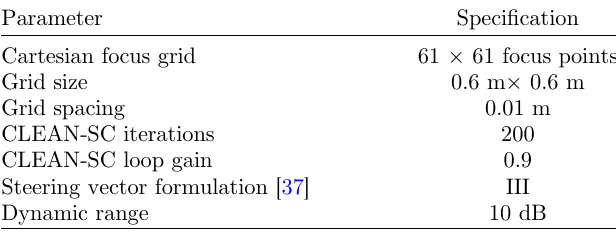
Table 3. Processing parameters for the acoustic source